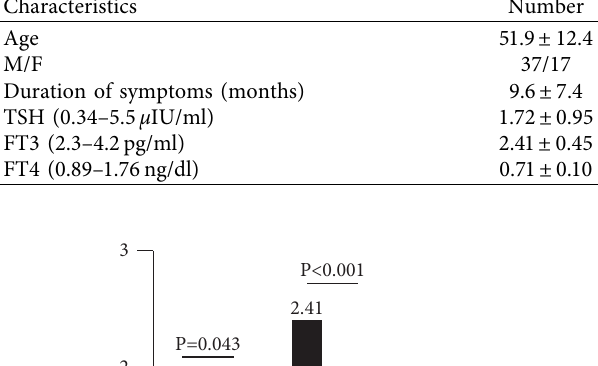
Table 2: Te clinical information and preoperative and post- operative thyroid function results of the 11 patients combined with primary hypothyroidism.